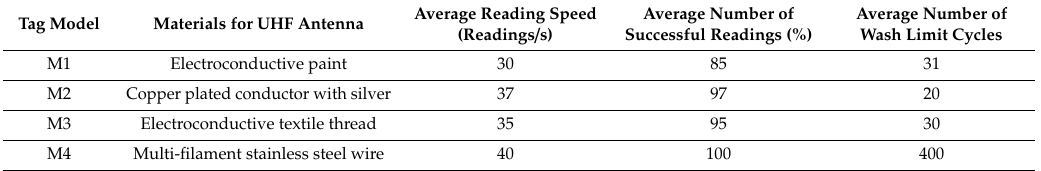
Table 4. Performance of passive RFID UHF tag models and number of wash limit